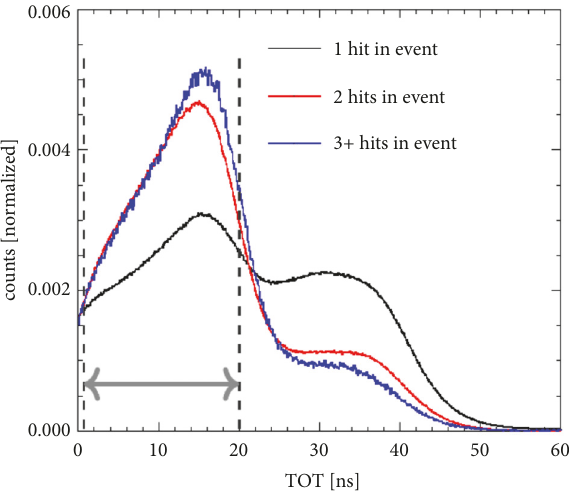
Figure 6: Distributions of time over threshold (TOT) values, for 𝛾 interactions observed in groups of 1, 2 and more within a coincidence time window of 2.5ns. In the samples with increasing number of coincident photons, the contribution of 𝛾 quanta from 3𝛾 annihilations increaseswith respecttoother processes.Gray lines and arrow denote the region used to identify 3𝛾 annihilation photon